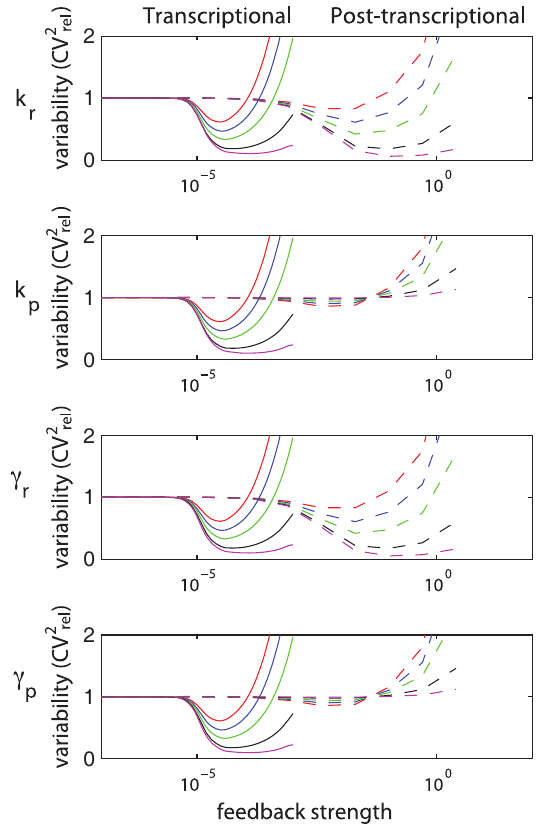
Figure 6. Comparison of total protein variability in transcrip- tional (solid line) and post-transcriptional (dashed line) self- repression circuits. Extrinsic variability in parameters (eqn. (13)): a ~ 0 : 01 (red), a ~ 0 : 03 (blue), a ~ 0 : 05 (green), a ~ 0 : 1 (black), and a ~ 0 : 2 (magenta). Feedback strength in transcriptional self-repression model is 1 = K d , in post-transcriptional k on = ( k off z c r (cid:2) ) .